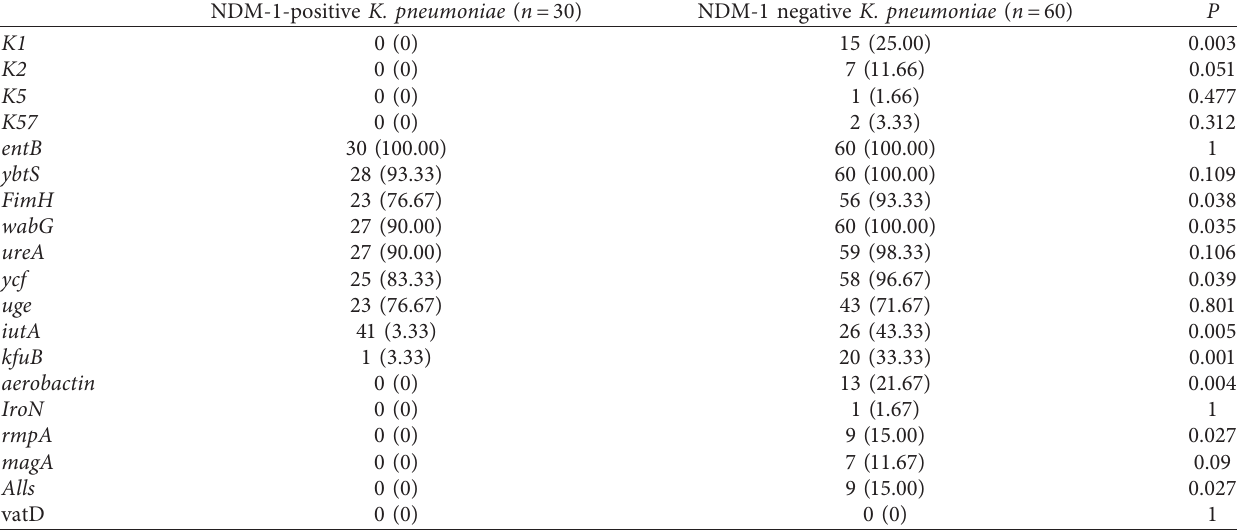
Table 3: Differences in the distribution of virulence genes and serotypes between NDM-1-positive K. pneumoniae and NDM-1-negative K. pneumonia (n